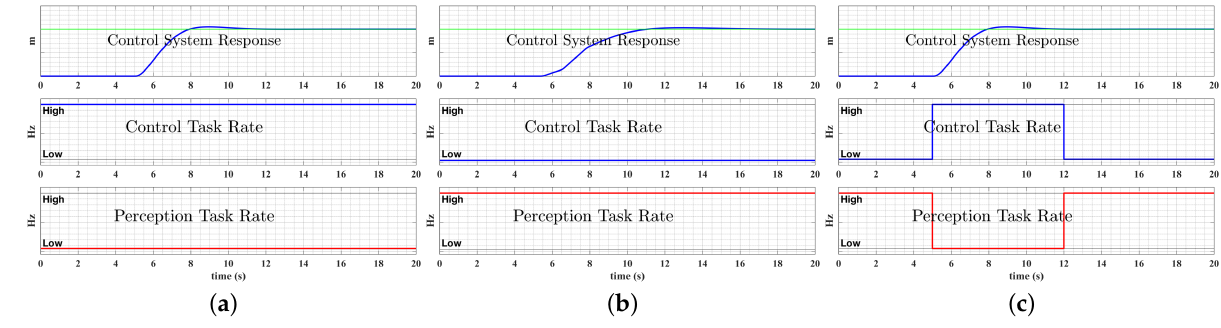
Figure 1. Different resource allocation strategies for UAS (example response for illustration pur- poses). ( a ) static high-rate control with low-rate perception; ( b ) static low-rate control with high-rate perception; ( c ) dynamic resource allocation for control and perception tasks.